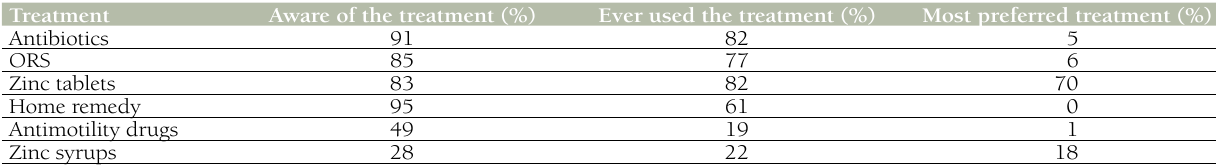
Table 5. Caregivers’ awareness of and experience with various diarrhea treatments and their most preferred treatment (n = 100